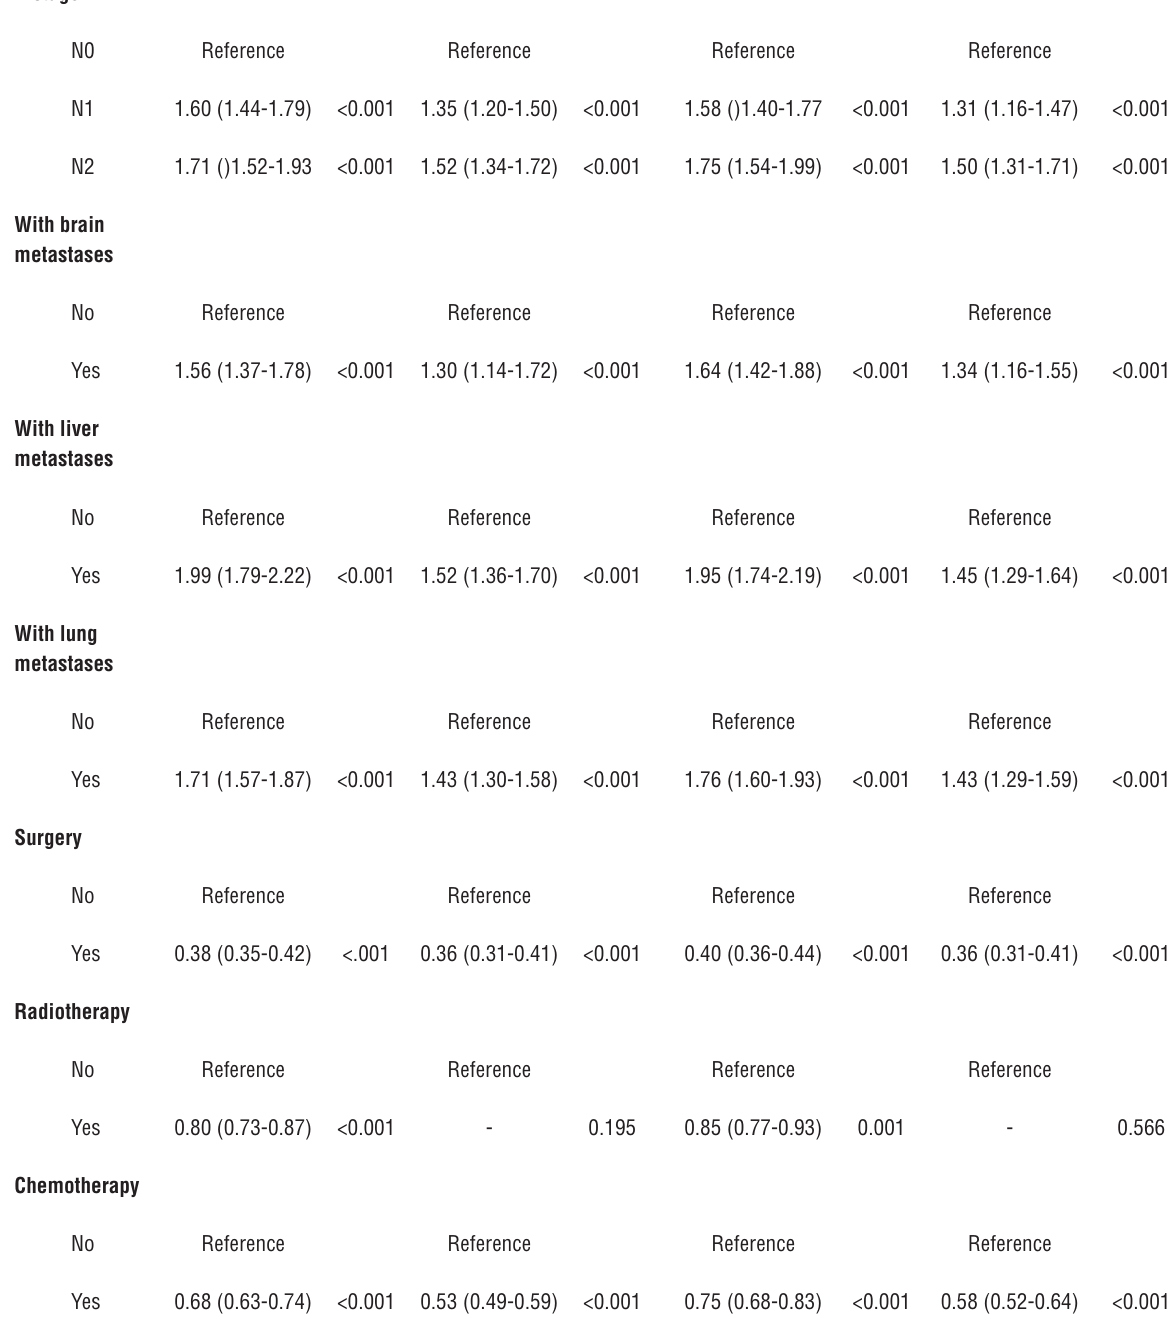
Table 2 - Univariate and multivariate analysis of overall survival (OS) and cancer-specific survival (CSS)